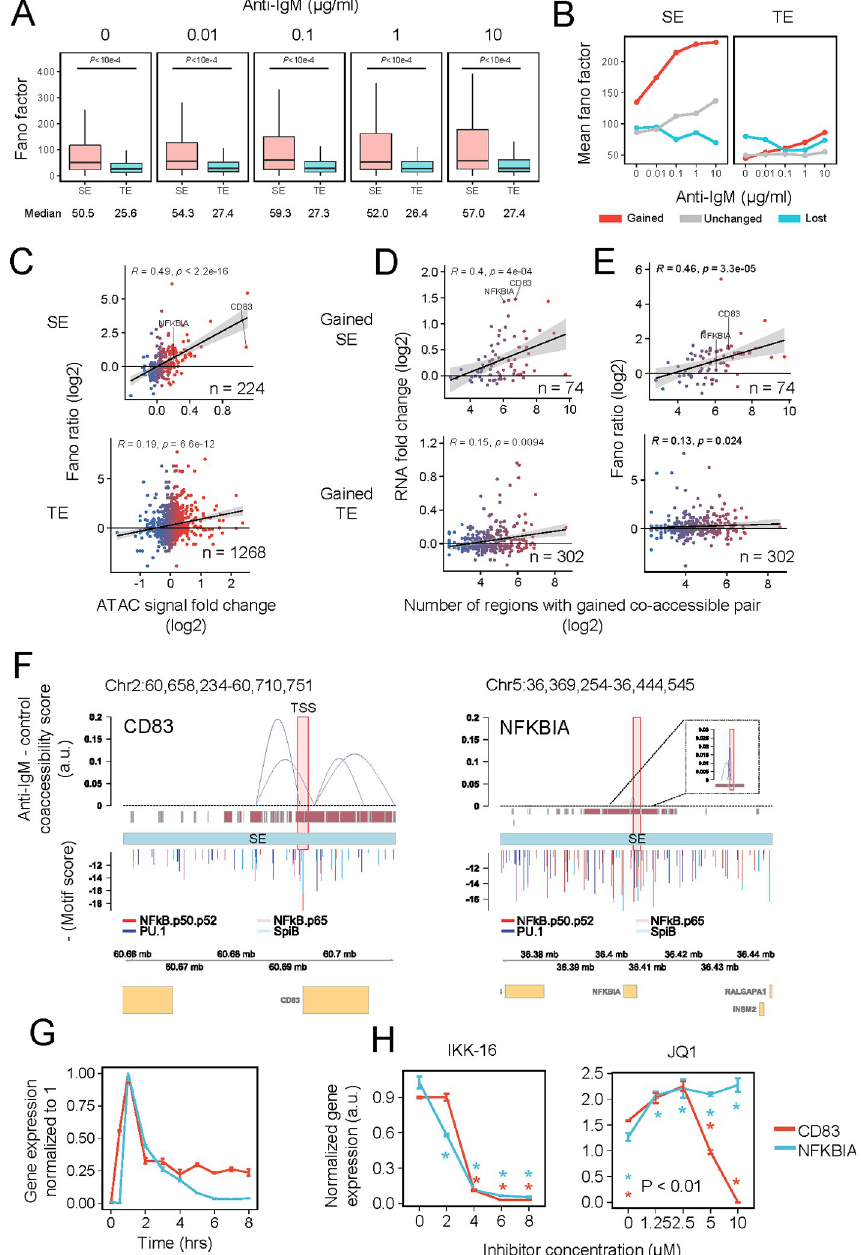
Fig 5. SE relationship with heterogeneity in gene expression. (A) Boxplot of Fano factor at various doses for DEGs associated with gained, lost, unchanged TE, and SE. Number of genes: SE, 224; TE, 647. P -value was calculated using Welch’s unpaired t-test with undersampling (n = 224). (B) Line plot of mean Fano factor change across dose for SE and TE associated DEGs. Number of genes: Gained SE, 82; Unchanged SE, 100; Lost SE, 42; Gained TE, 242; Unchanged TE, 384; Lost TE, 21. (C) Correlation plot of Fano factor ratios (10 vs. 0 μ g/mL anti-IgM-stimulated cells) against ATAC intensity fold changes at SEs and TEs of DEGs. R = Spearman correlation. (D) Correlation plot of RNA fold changes (activated vs inactivated cells) against numbers of co-accessible pairs. (E) Correlation plot of Fano factor ratios (10 vs 0 μ g/mL anti-IgM-stimulated cells) against numbers of co-accessible pairs. (F) Co-accessibility score differences obtained using Cicero between stimulated and unstimulated cells shown between genomic regions interacting with regions ± 1 kb around the annotated start site of CD83 (left) and NFKBIA (right). (G) Time-course RT-qPCR of CD83 and NFKBIA upon stimulation with 1 μ g/mL anti-IgM. Gene expression was normalized to GAPDH . Error bar = SD. (H) RT-qPCR results of IKK-16 (left) and JQ1 (right) treatment 60 min prior to stimulation with 1 μ g/mL anti-IgM for 60 min (n = 3). Gene expression was normalized to GAPDH , and P -values were calculated using Student’s unpaired t-test against dose 0 for each dose point. Error bar = SD.